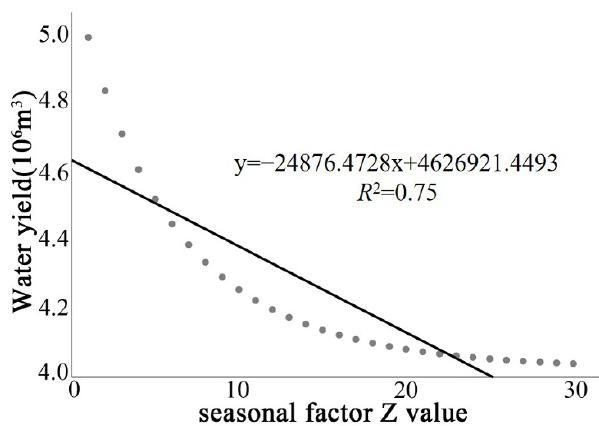
Figure 2. The correlation between water source content and seasonal factor Z value.